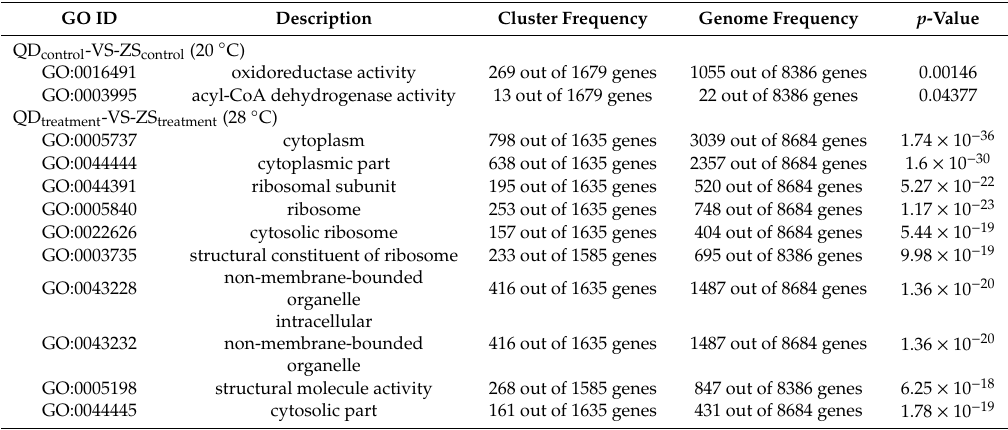
Table 3. Results of the enrichment analysis of Gene Ontology (GO) terms of the di ff erentially expressed unigenes between two populations (ZS control : Zhoushan population at 20 ◦ C; ZS treatment : Zhoushan population at 28 ◦ C; QD control : Qingdao population at 20 °C; QD treatment : Qingdao population at 28 ◦ C).